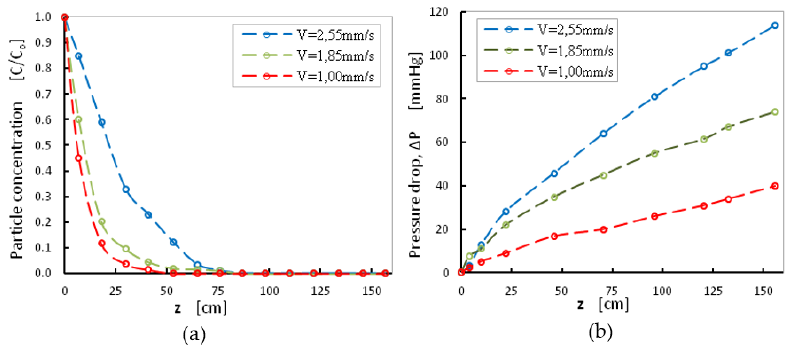
Figure 6. ( a ) Normalized particle concentration versus sand-bed depth and ( b ) Pressure drop versus sand-bed depth. Effect of superficial velocity for C 0 = 70NTU, sand grains with fine size distribution < 1 mm, for 8 h of filtration.